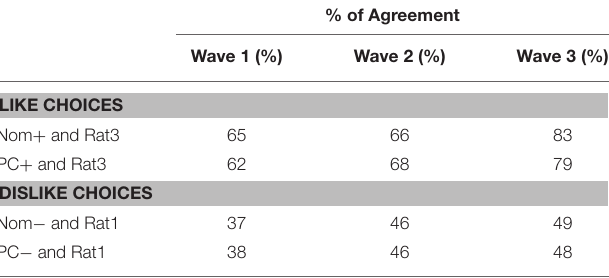
TABLE 2 | Agreement between sociometric tasks for like and dislike